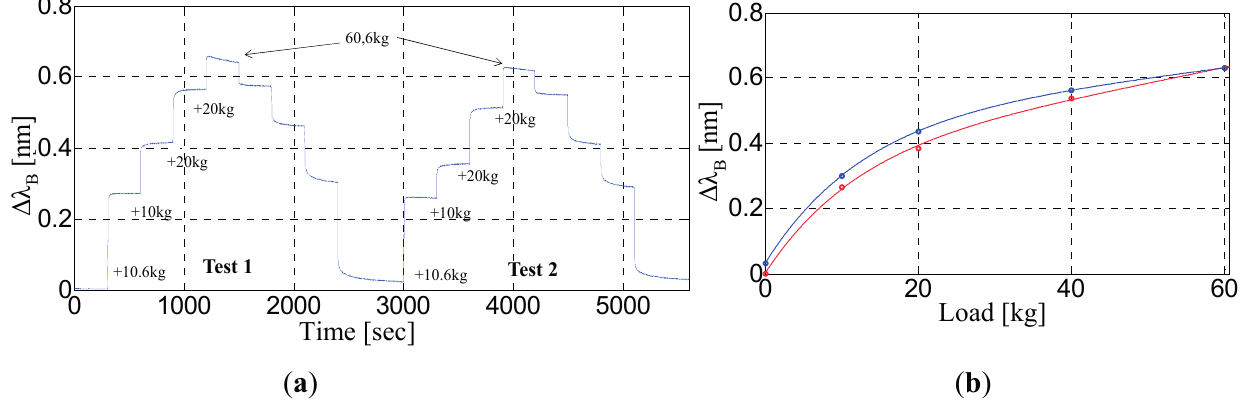
Figure 4. ( a ) Bragg wavelength shift versus time under the application of different weight plates; ( b ) Sensitivity curve: Ascent (Red) and the descent